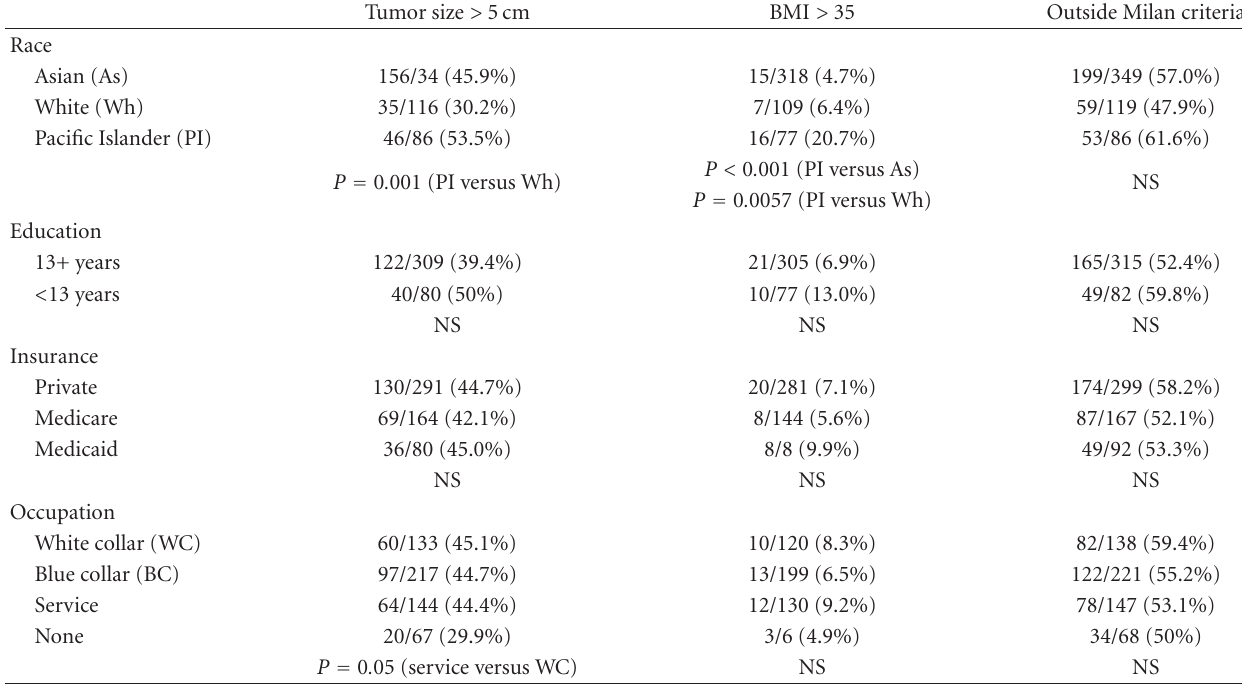
Table 3: Di ff erences in exclusion criteria for transplant by race, education, insurance, and